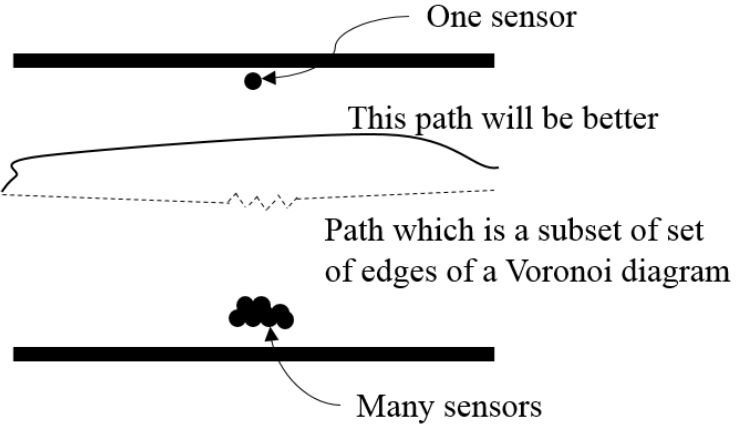
Figure 1. An example showing the shortcomings of a minimum exposure path found with a Voronoi